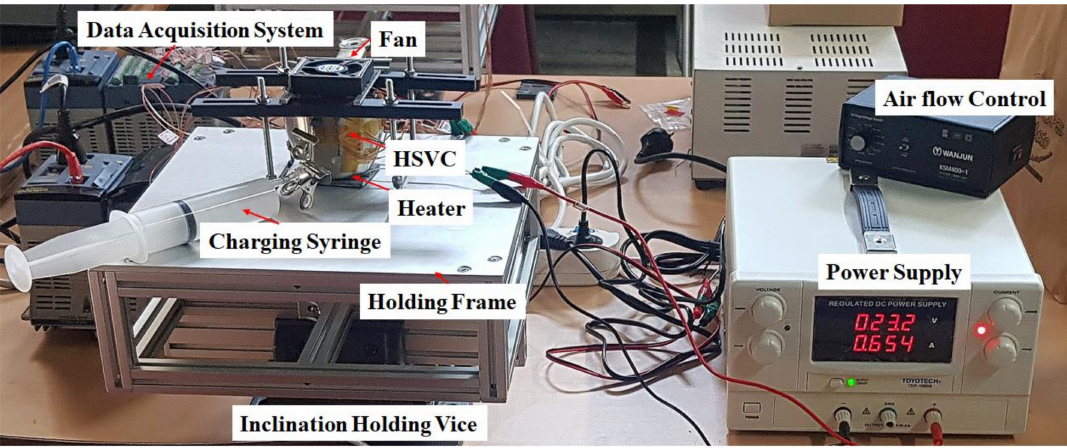
Figure 4. Experimental